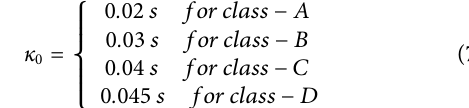
Frontiers in Earth Science |